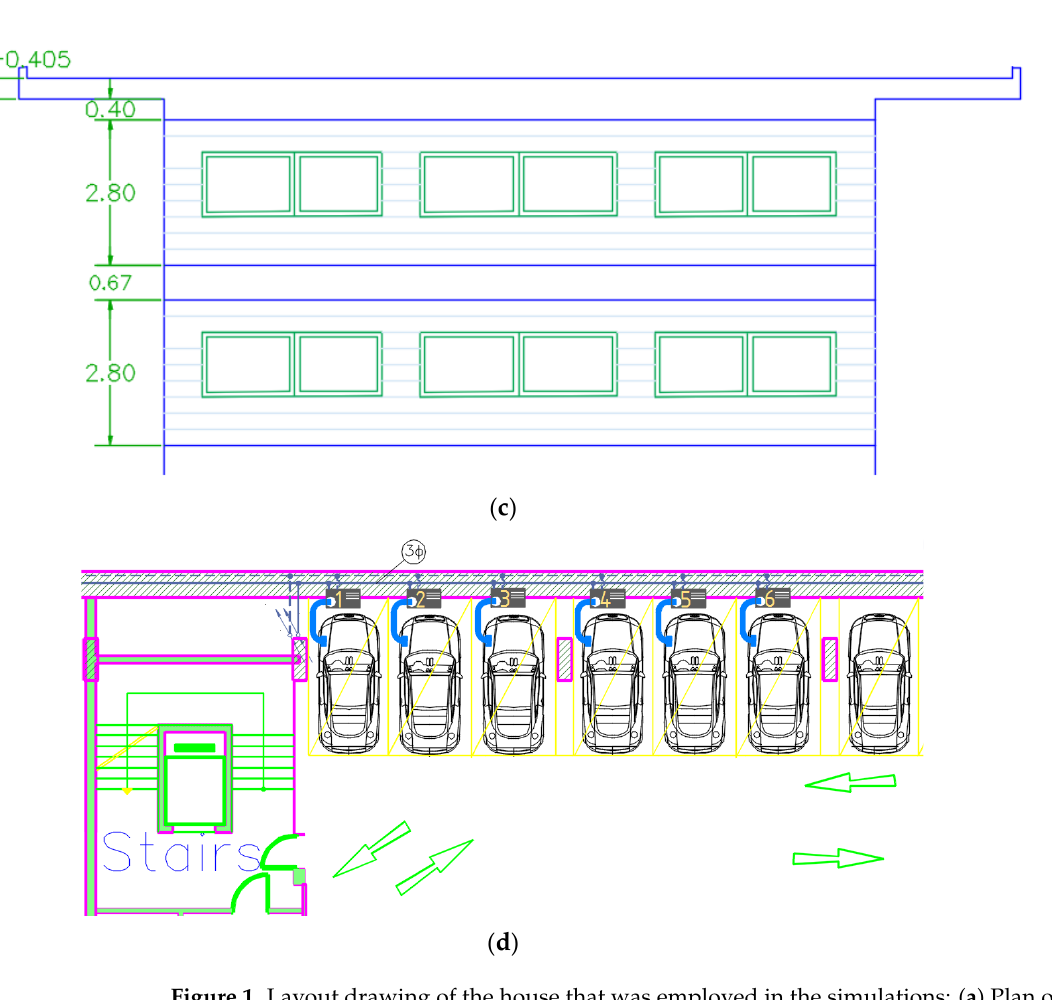
Figure 1. Layout drawing of the house that was employed in the simulations: ( a ) Plan of a typical floor level, ( b ) plan of rooftop PV installation, ( c ) eastward view of the third and fourth levels, and ( d ) part of the EV car parking places with chargers # 1 to 6 at the building’s basement. Dimensions in meters (m).